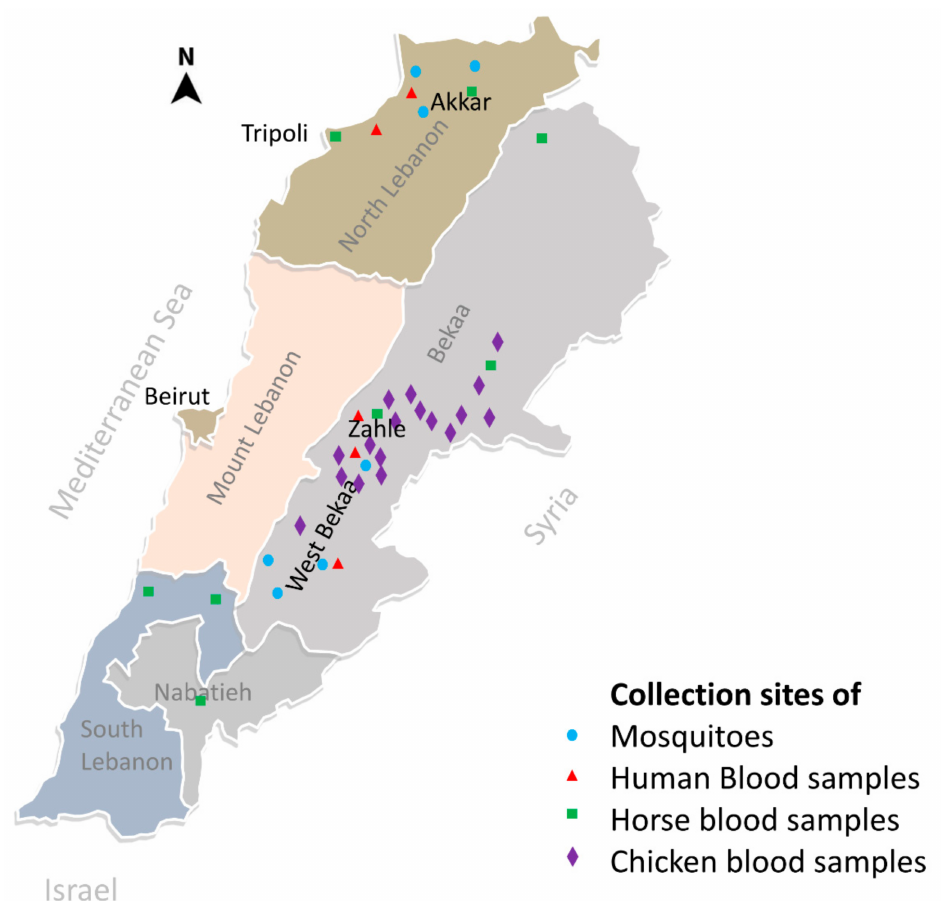
Figure 1. Map of Lebanon indicating the collection sites of mosquitoes and blood from human, horse, and chicken hosts. Equine blood was collected from June to October 2015 from farms and riding clubs in rural areas in several districts of the Bekaa region (including West Bekaa and Zahle), North region (including Akkar), and South regions (Figure 1). Information on each horse